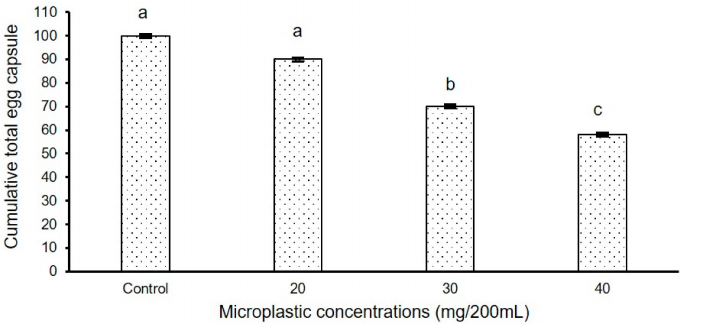
Figure 6. Cumulative total (Mean ± SE) of egg capsule production/individual by P. acuta for 93 days of experimental duration in control, and in the medium with three concentrations (20, 30 and 40 mg/200 mL) ( n = 10) of polystyrene microplastics. Data points with differences superscribed with different letters are statistically significant ( p <